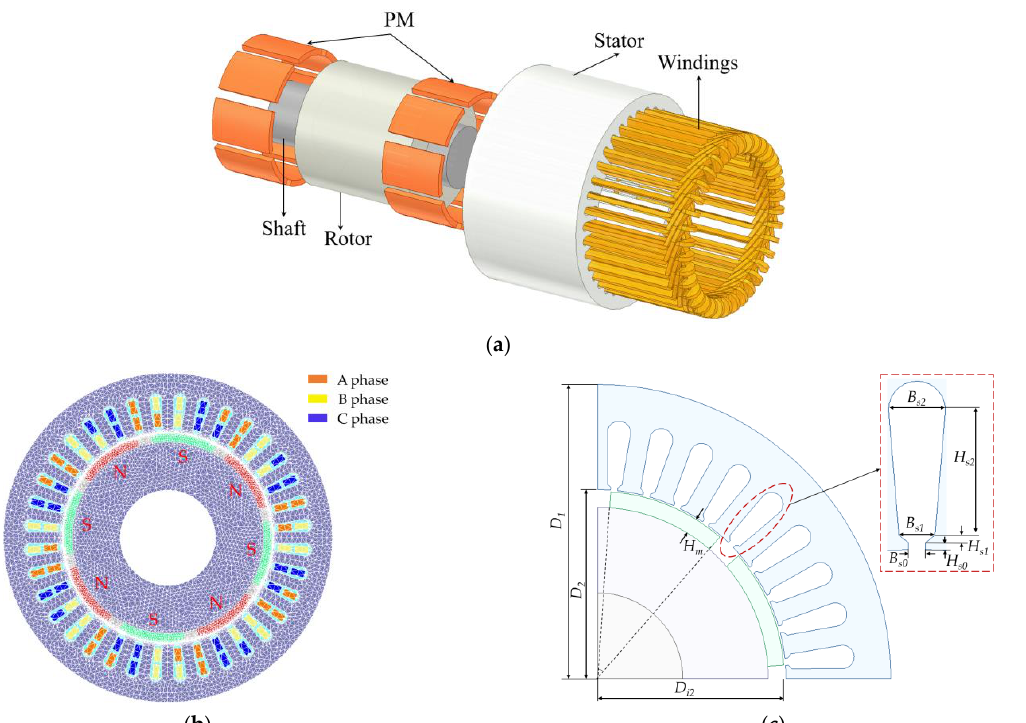
Figure 1. Model of SPMSM: ( a ) geometric model; ( b ) FEM; ( c ) parameterization model. Table 1. Basic parameters of SPMSM.